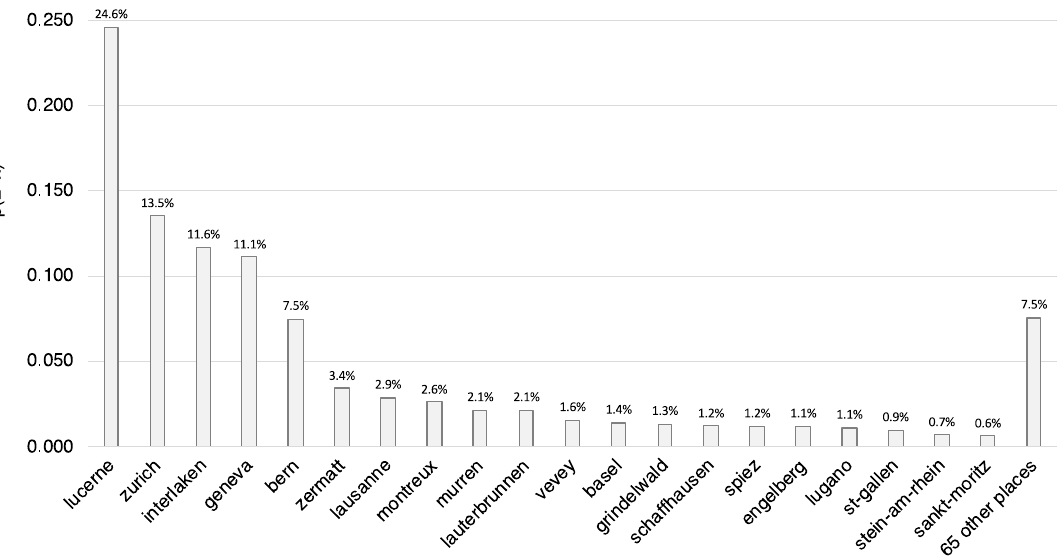
Figure 5. Frequency of comments by users in an interactive heatmap zoomed to the area of Lucerne.